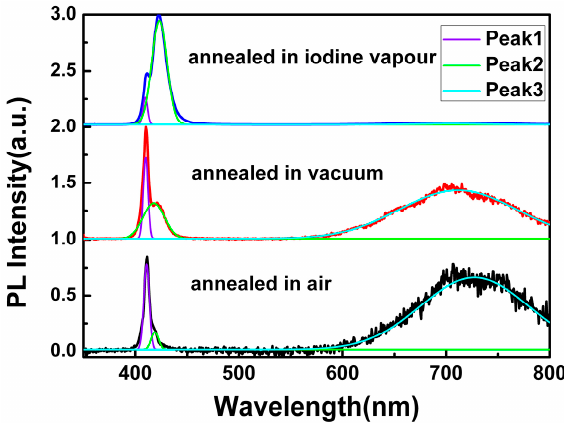
Figure 5. PL spectra of CuI thin films annealed in different environments. Table 1. PL parameters of CuI thin films with and without annealing treatment.